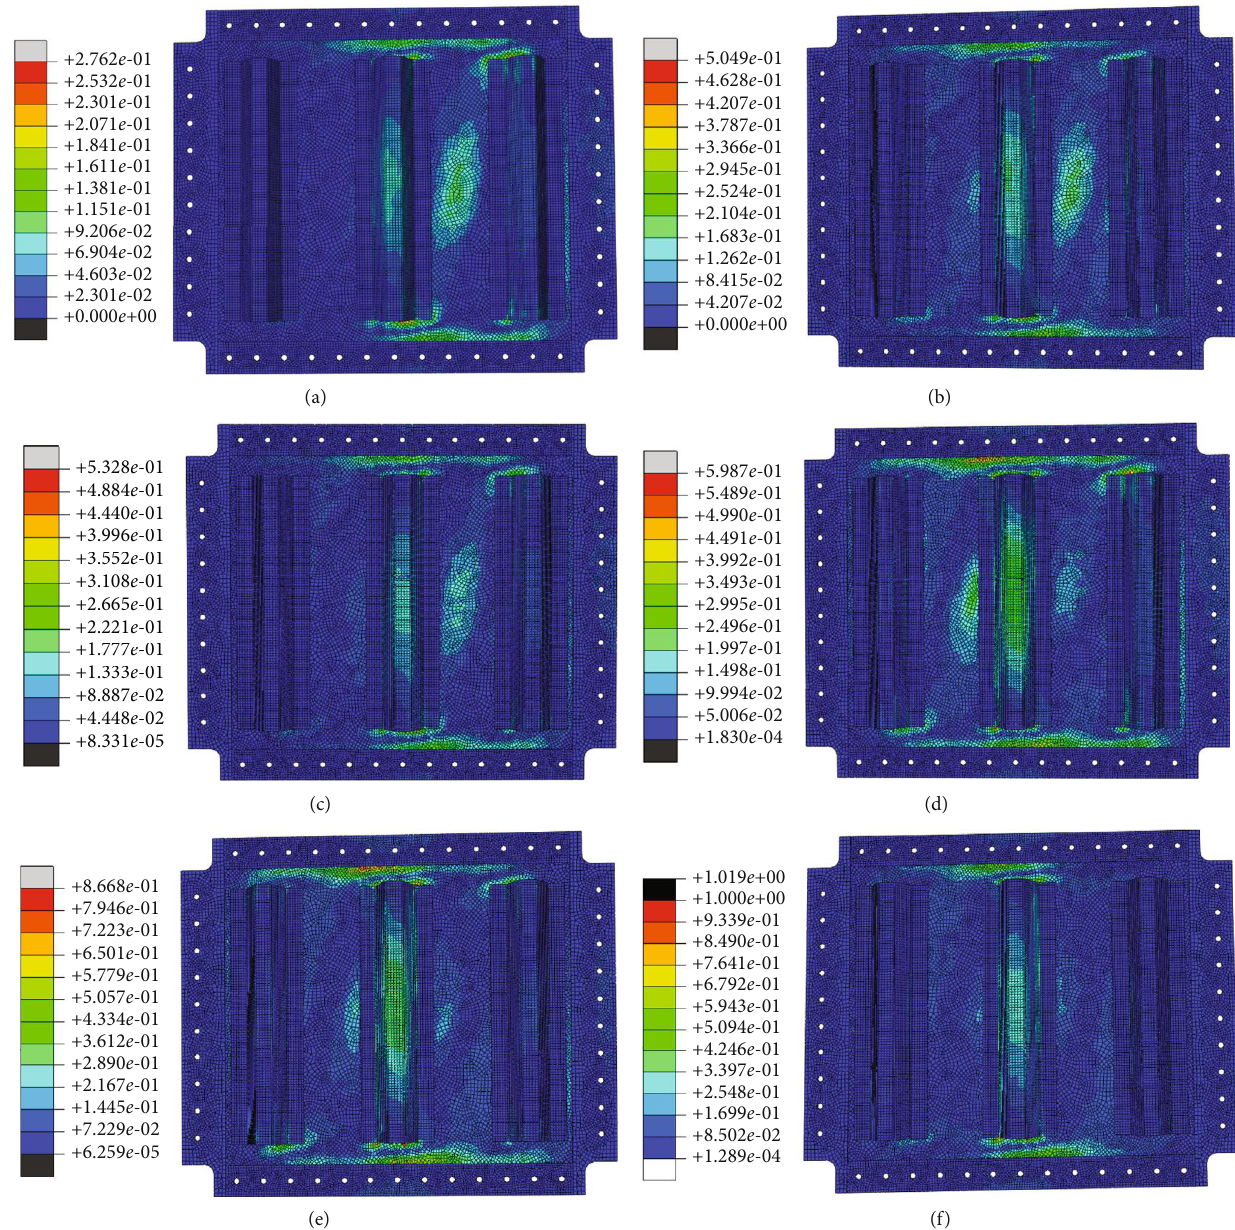
Figure 25: Tsai-Wu failure coe ffi cient of the composite-reinforced wall panels. (a) 15 ° , (b) 20 ° , (c) 25 ° , (d) 45 ° , (e) 60 ° , and (f) 75 °